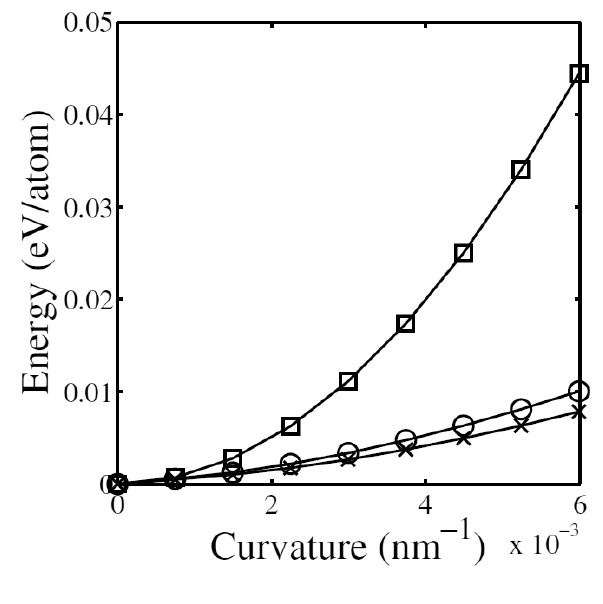
Energy curves for a bent 34-walled nanotube with respect to the bending curvature. Shown are the strain energy for fictitiously uniform bending (squares), the strain energy for actually rippled deformation (crosses), and the total energy ( i.e. , sum of the strain energy and the vdW one) for rippled deformation (circles). Reprinted from Reference